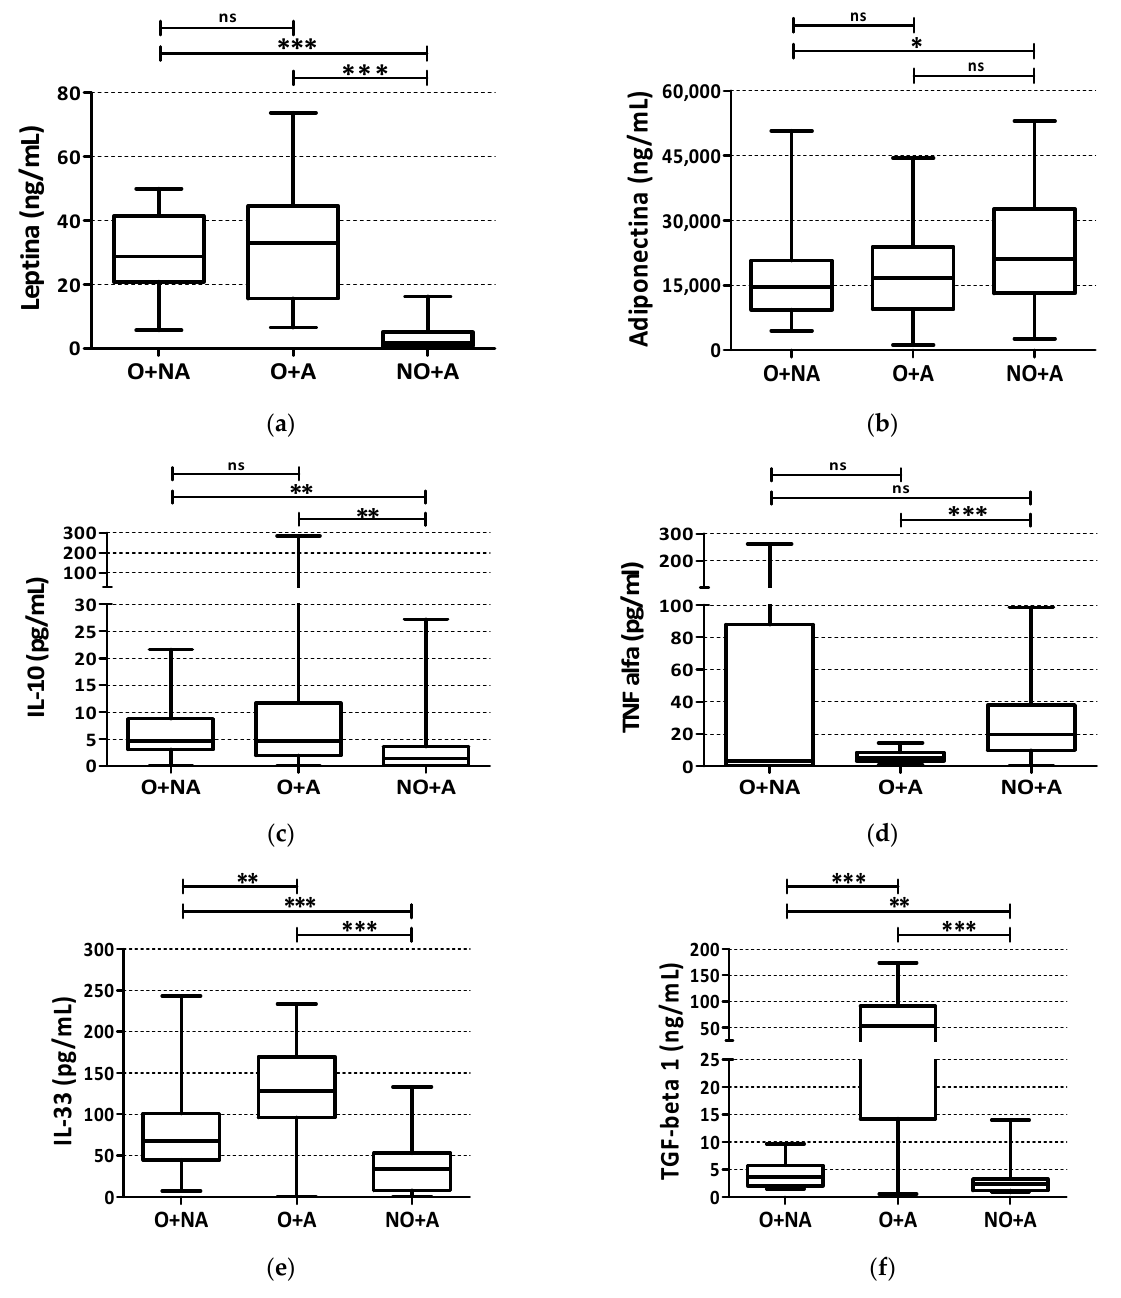
Figure 2. Cytokine pattern of children with abnormally high body mass index without asthma (O + NA), with abnormally high body mass and asthma (O + A) and children with asthma and normal body weight (NO + A). The boxes include the interquartile values, horizontal line in the box points out median value, the whiskers include minimum and maximum values. Statistical test: Mann–